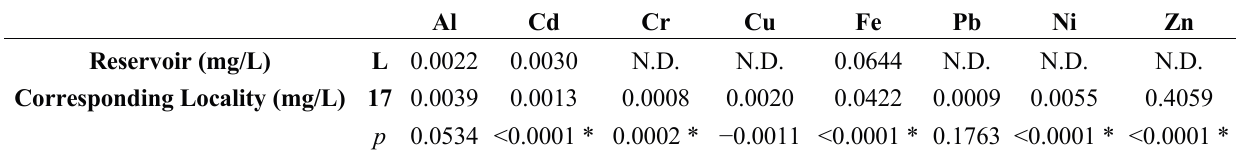
Table A9. Statistical variation between Reservoir L and its feeding Locality 17.